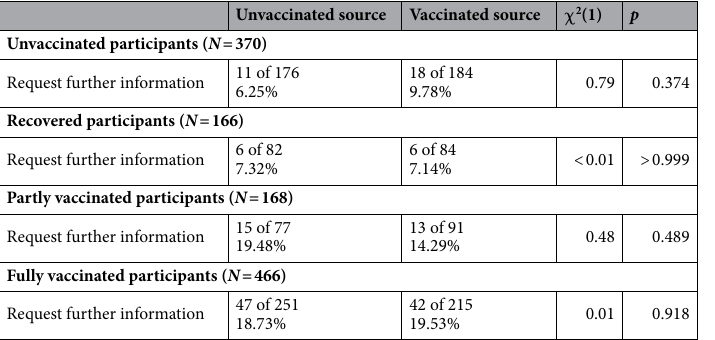
Table 4. Behavioral planning by comment source for each vaccination status participant group. Standard deviations, ranges, and skew are in parentheses. Reporting adjusted estimates for Cohen’s d.